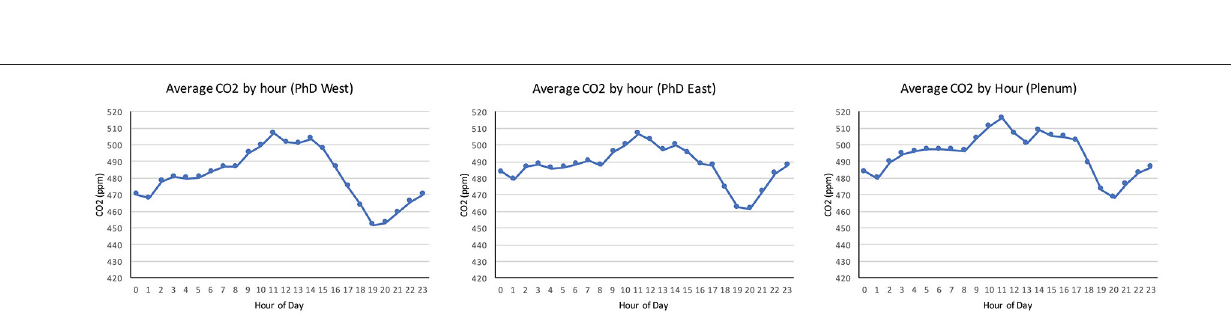
Frontiers in Built Environment | www.frontiersin.org